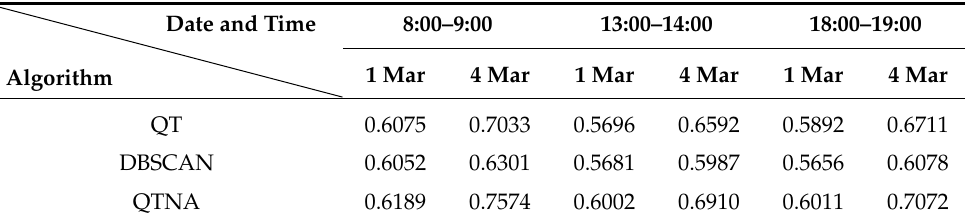
Table 2. Performance comparison of clustering algorithms based on drop-off locations during the same time period on different